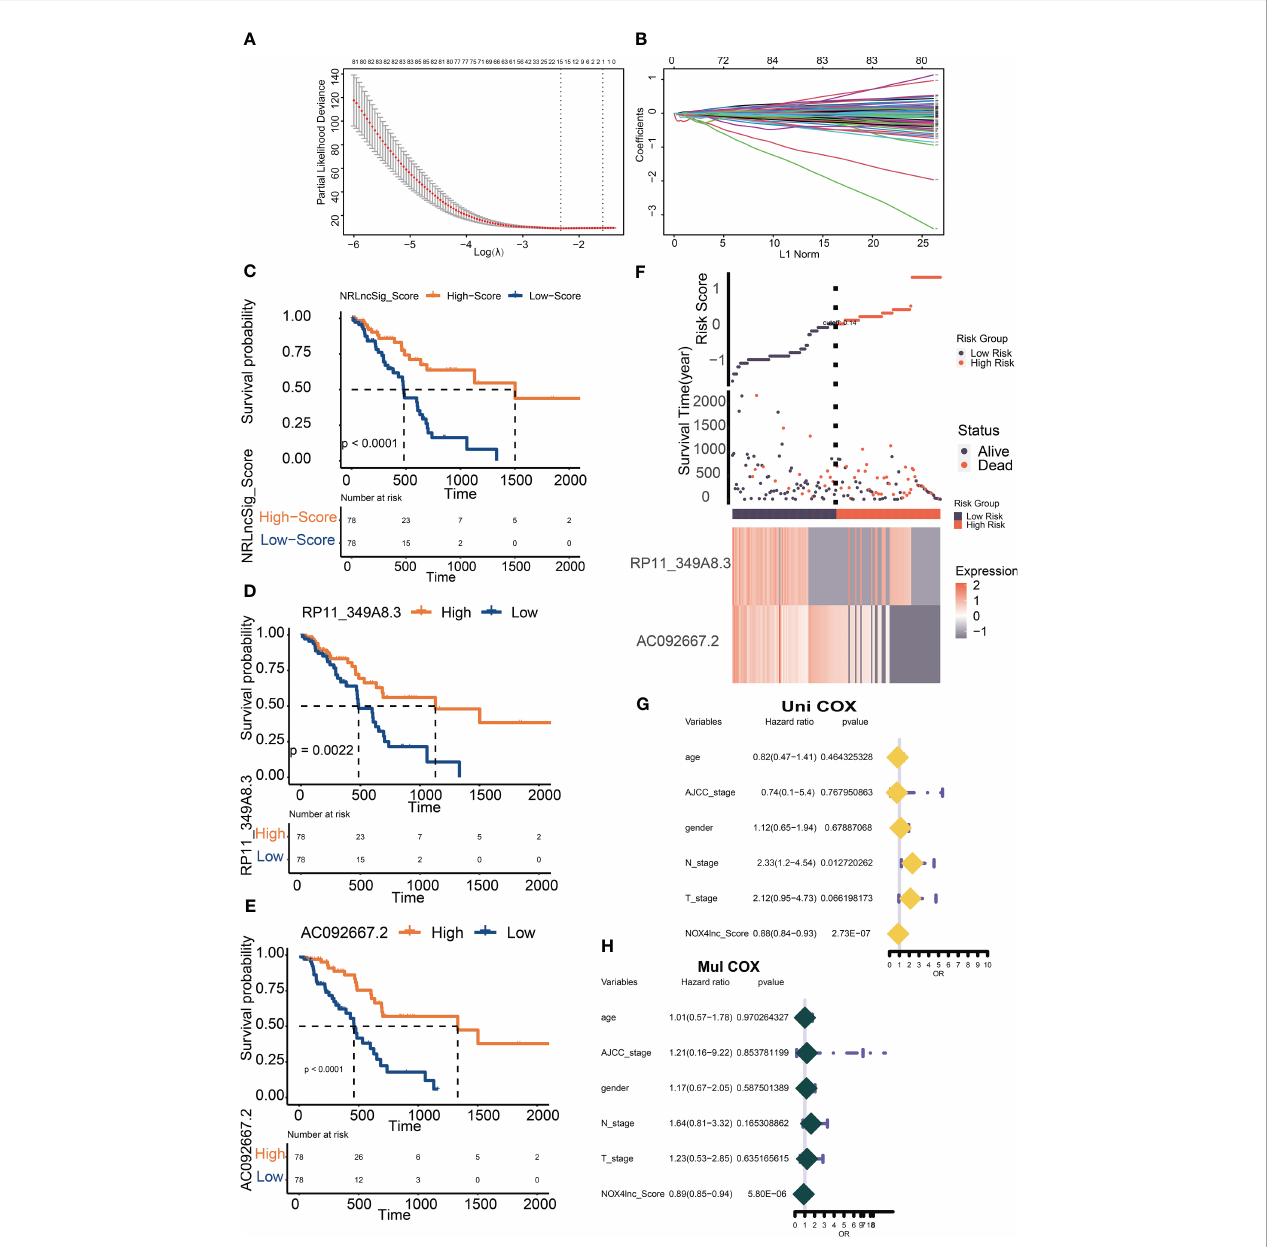
FIGURE 5 Screening and veri fi cation of prognostic NOX4-related lncRNAs. (A) Plots for LASSO expression coef fi cients of NOX4-related lncRNAs. (B) Cross- validation plot for the penalty term. (C) Kaplan-Meier evaluated the overall survival of the low-score or high-score patients predicted by NRS Score. (D, E) Kaplan – Meier survival curve of overall survival based on the expression of RP11-349A8.3, AC092667.2. (F) Rank, distribution, and median values obtained based on risk scores; the survival status and the expression of lncRNA in different groups of patients with pancreatic cancer. (G, H) Cox- regression analysis of NRS Score and clinicopathologic